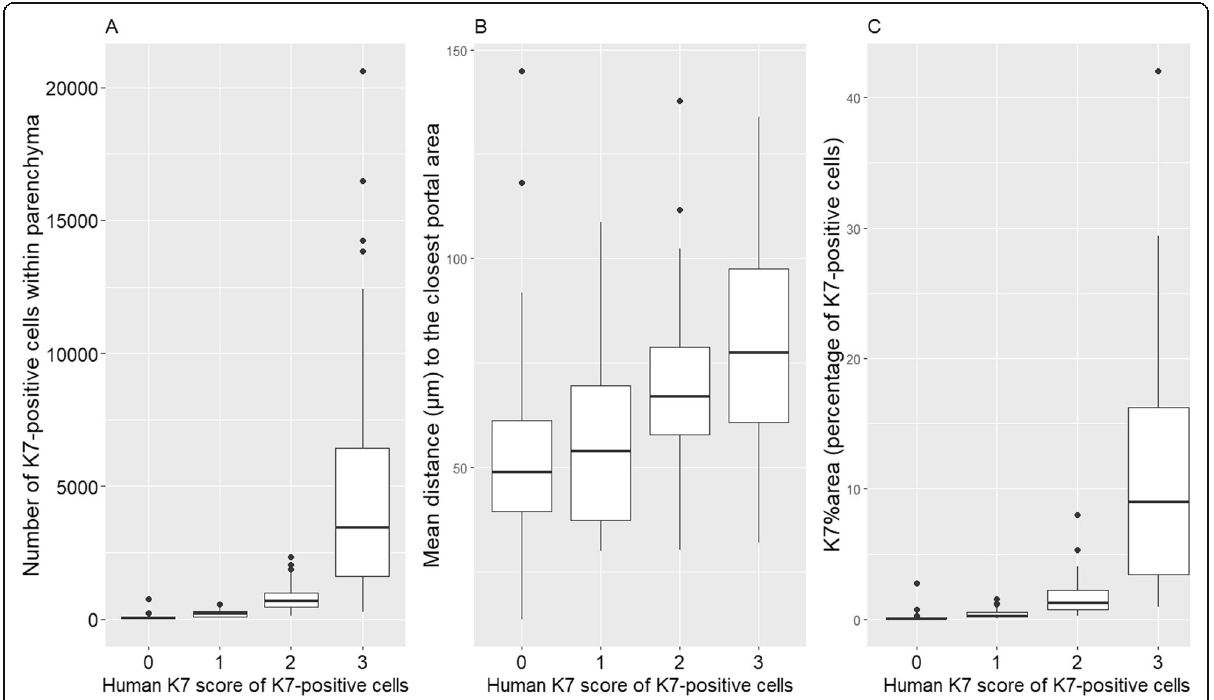
Fig. 5 a - c The human estimate of the K7-positive hepatocytes (human K7 score) binned into three categories (0 – 3) according to the Nakanuma classification [19] in relation to the distribution of K7-positive hepatocytes measured by the K7-AI Model. a Number of K7-positive hepatocytes and their distribution within the categories of human K7 score (0 – 3) estimated by a human pathologist. b Mean distance ( μ m) of the K7-positive hepatocytes from their closest portal area and their distribution within the categories of human K7 score. c Percentage of area of K7-positive hepatocytes (K7%area) in each specimen distributed within the categories of human K7 score